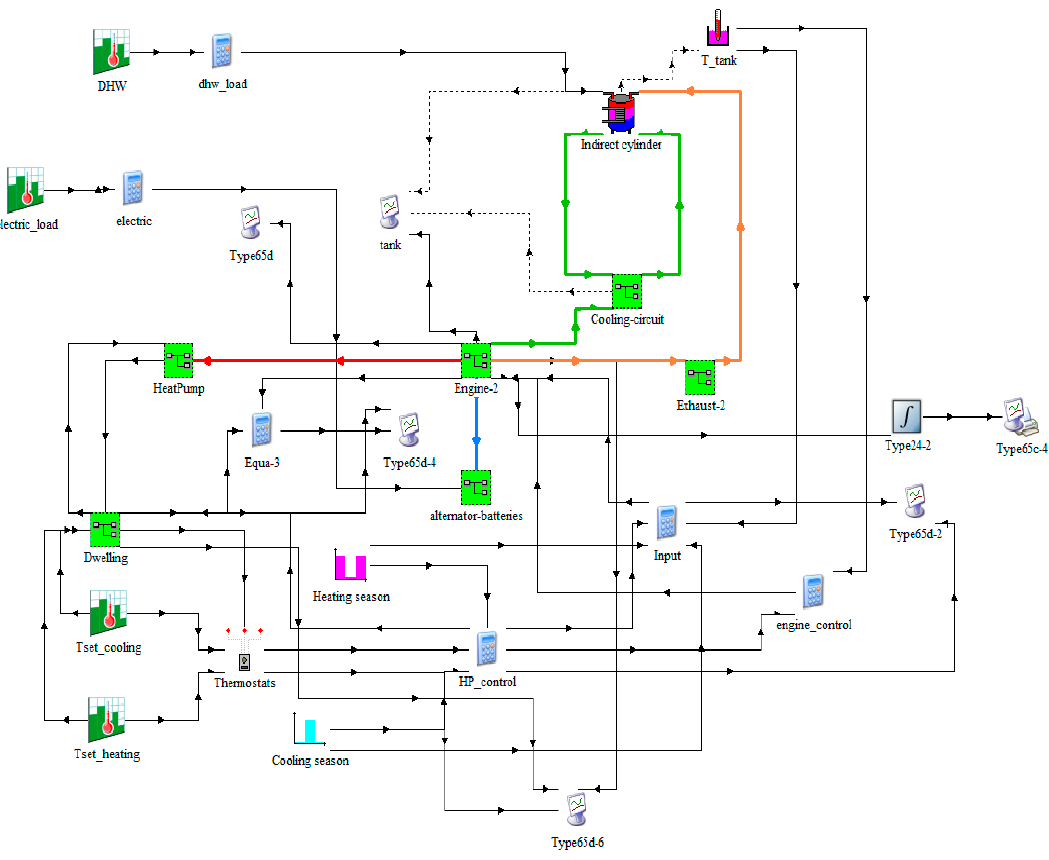
Figure 8. General layout of the simulation in TRNSYS.